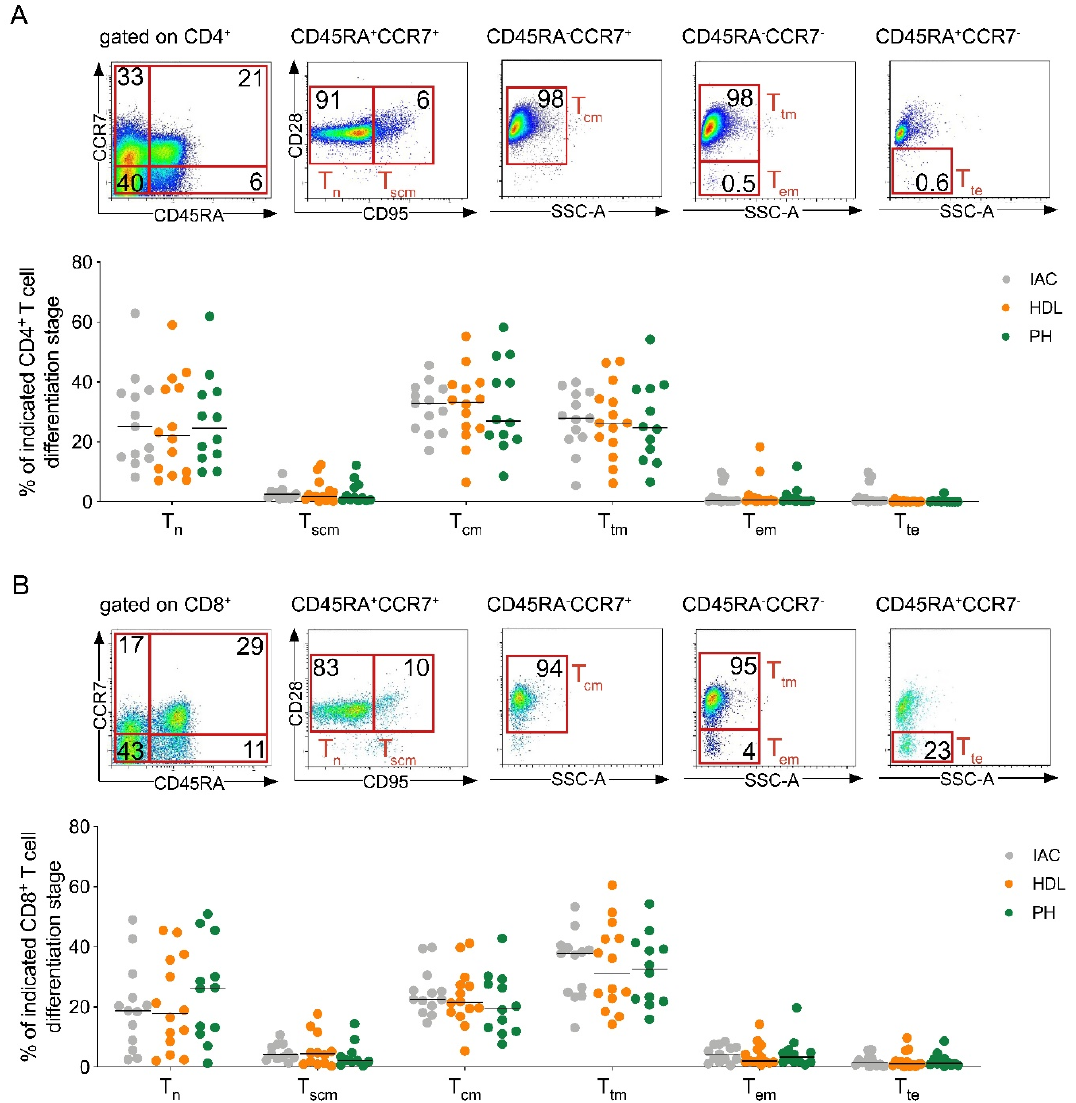
Figure 2. Central and transitionally memory T cells constitute the predominant T cell differentiation stages in PDAC-draining lymph nodes. ( A ) Representative flow plots (top) and frequency (below) of T cell differentiation stage in lymph nodes of the indicated location for CD4 + and ( B ) CD8 + T cells. Tn, naïve (CD45RA + CCR7 + CD28 + CD95 - ); Tscm, stem cell memory (CD45RA + CCR7 + CD28 + CD95 + ); Tcm, central memory (CD45RA - CCR7 + CD28 + ); Ttm, transitionally memory (CD45RA - CCR7 - CD28 + ); Tem, effector memory (CD45RA - CCR7 - CD28 - ); Tte, terminal effector (CD45RA + CCR7 - CD28 - ). IAC, interaortocaval; HDL, hepatoduodenal ligament; PH, pancreatic head. Each point represents data from one patient. Data, median. One-way ANOVA.